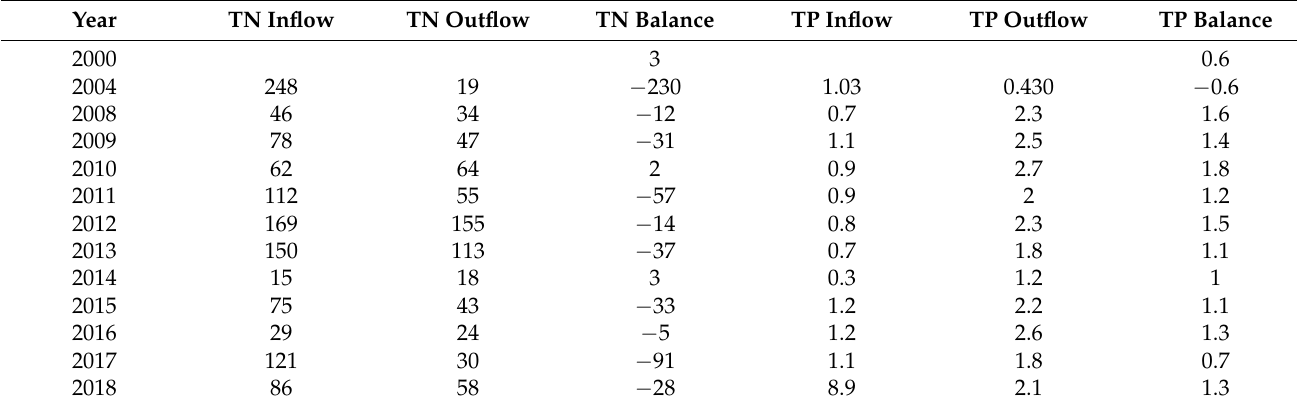
Table 1. Annual TP and TN mass load balances (tons/year) in Lake Agmon during 2008–2028: TN and TP inputs (inflow), output (outflow), and balance (output minus input)